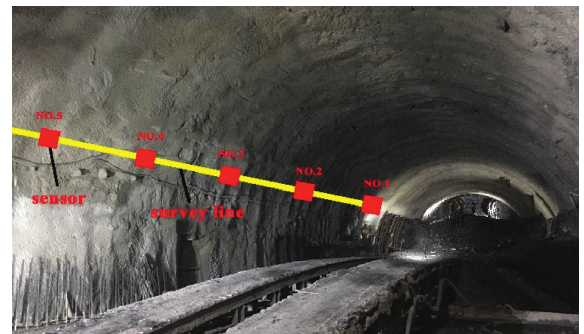
Figure 6: Measuring point arrangement diagram along